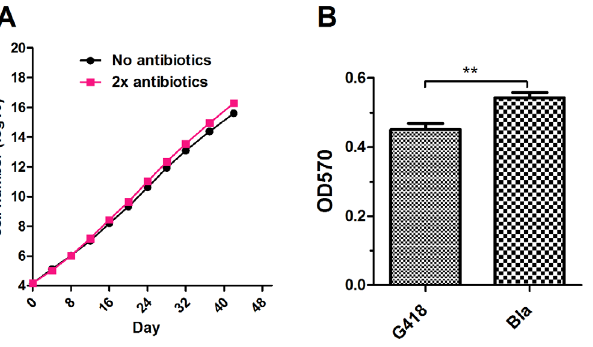
Fig. 3. Stable transgene expression of established SNL DG5 feeder cell. (A) The cells were seeded into 24-well plate and each was in duplicate. Antibiotics or antibiotics-free medium were added into each well for cell culture. The 2x antibiotics concentration was 80 m g/mL zeocin, 200 m g/mL hygromycin, 4 m g/mL puromycin and 6 m g/mL blasticidin respectively. The cell numbers were calculated every four days during each subculture and identical numbers of cells were seeded for continuous passaging. (B) MTT assay for comparison of PiggyBac mediated blasticidin resistance gene with original G418 resistance gene expression after long time cell culture.